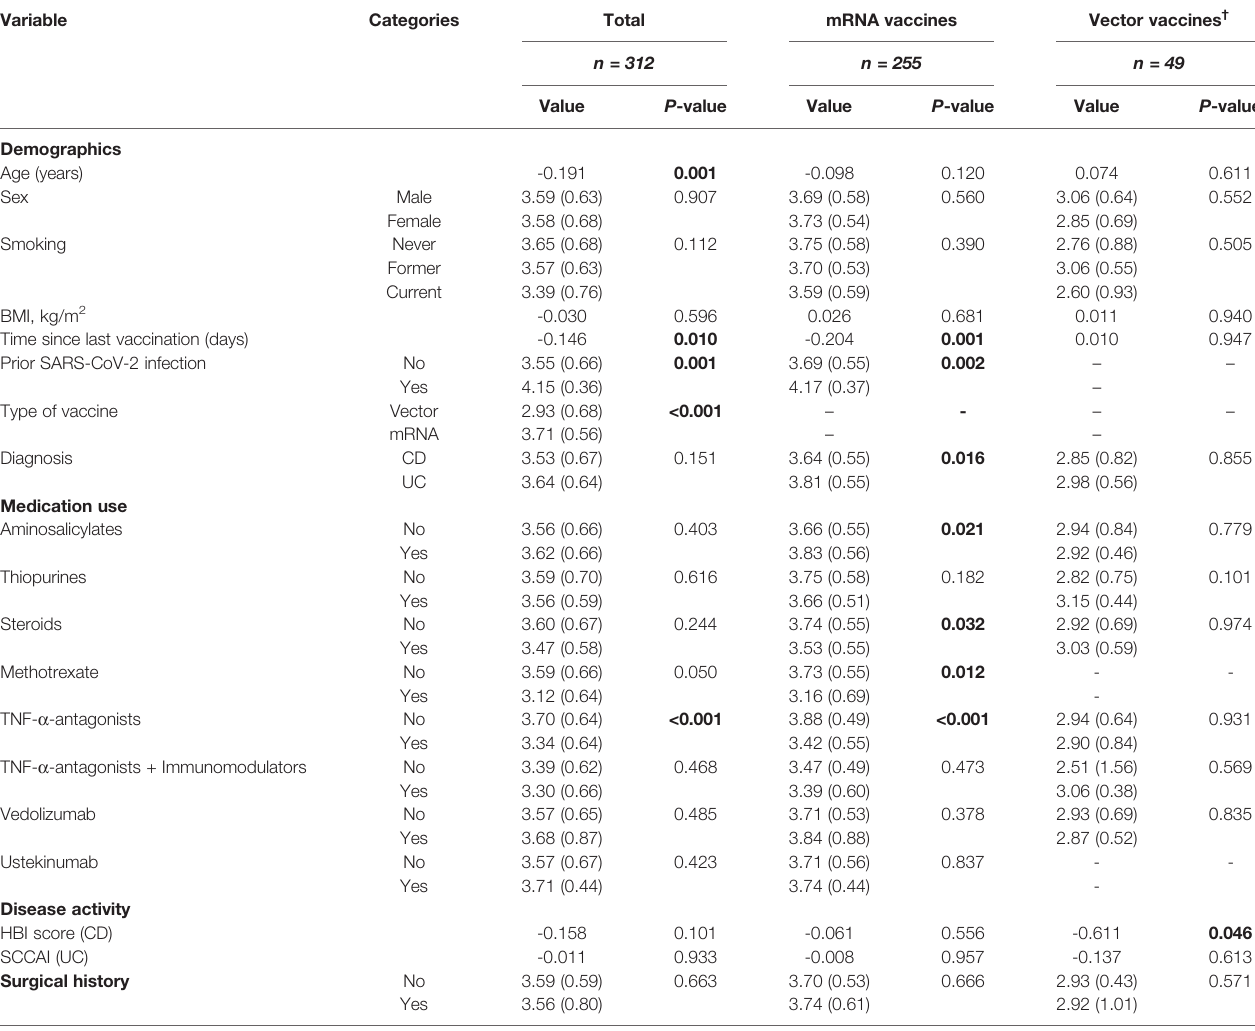
TABLE 2 | Univariable associations between patient characteristics and log-transformed anti-SARS-CoV-2 antibody titers.